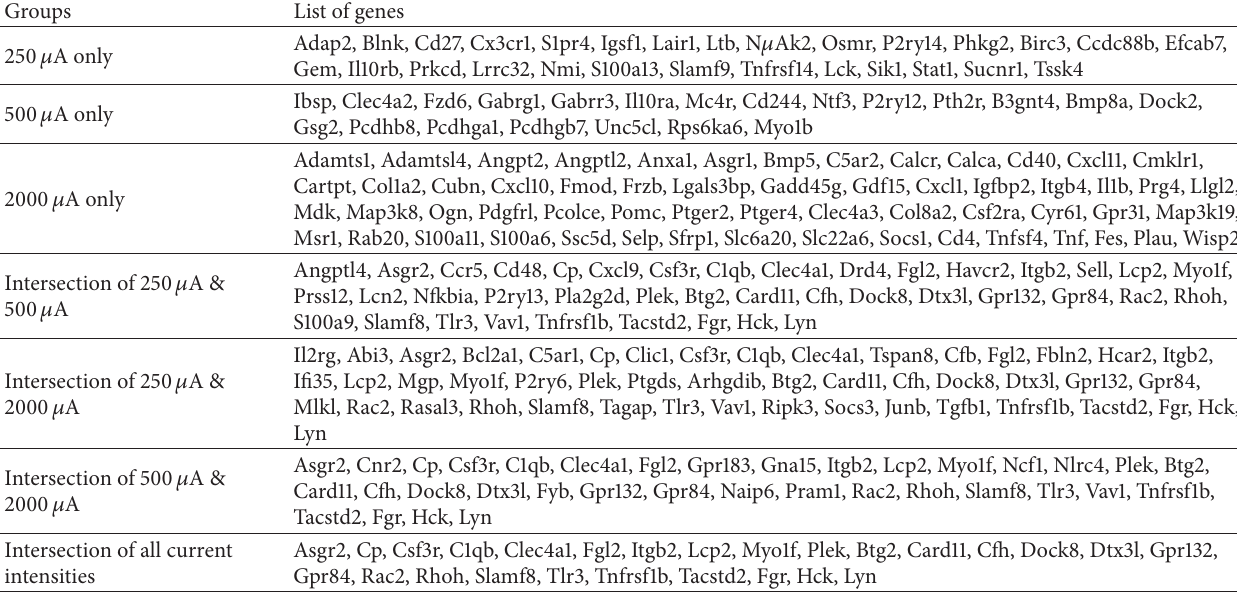
Table 1: Genes in the cell communication subcategory that were detected from RNA-Seq data sets.